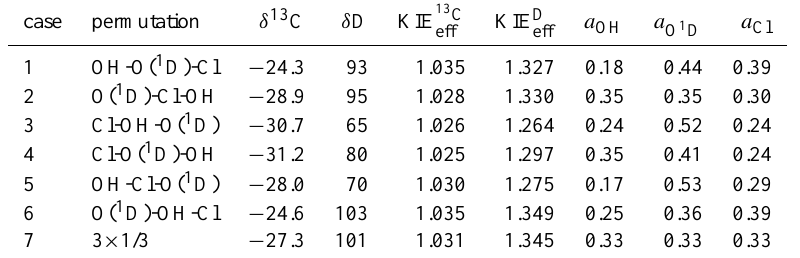
Table 7. Final isotope fractionation (column 3 and 4) and effective kinetic isotope effect KIE eff (column 5 and 6) fractionation for different permutations (column 2) of the three methane sinks. The simulated δ -values are different and thus the KIE eff is pathway dependent. Case 7 is a parallel removal by all three sink processes of equal strength, i.e. KIE eff is constant along the fractionation pathway. case